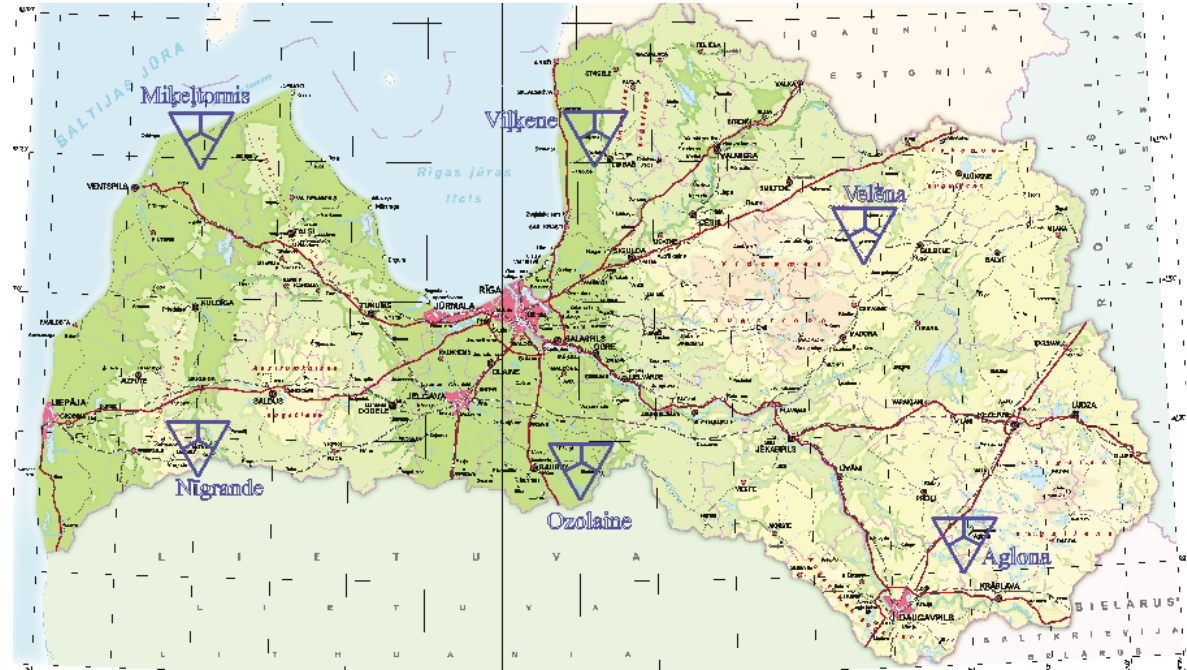
Fig. 1. Geomagnetic repeat stations in